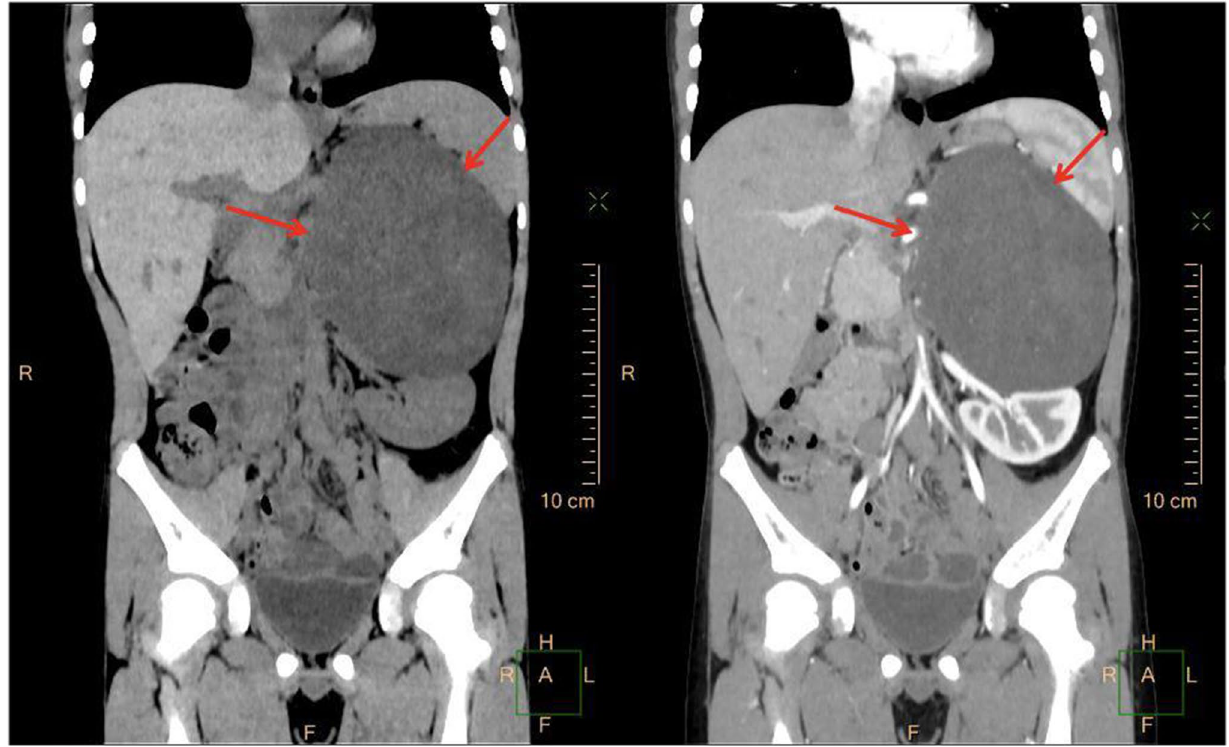
Fig. 1 CT showed a large oval mass of homogenous soft-tissue density above the left kidney with slight